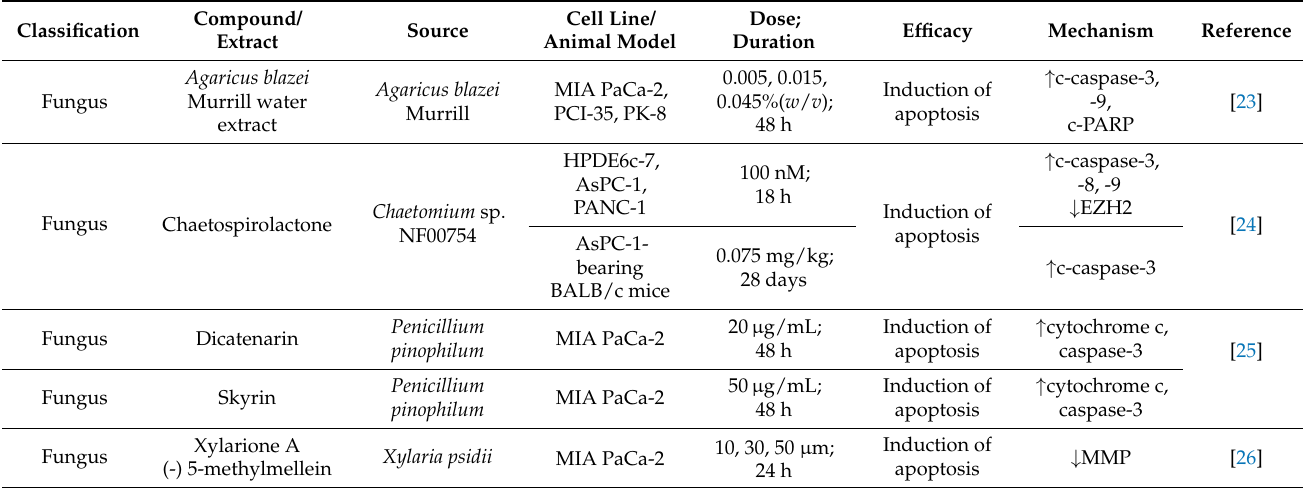
Table 1. Apoptosis inducing